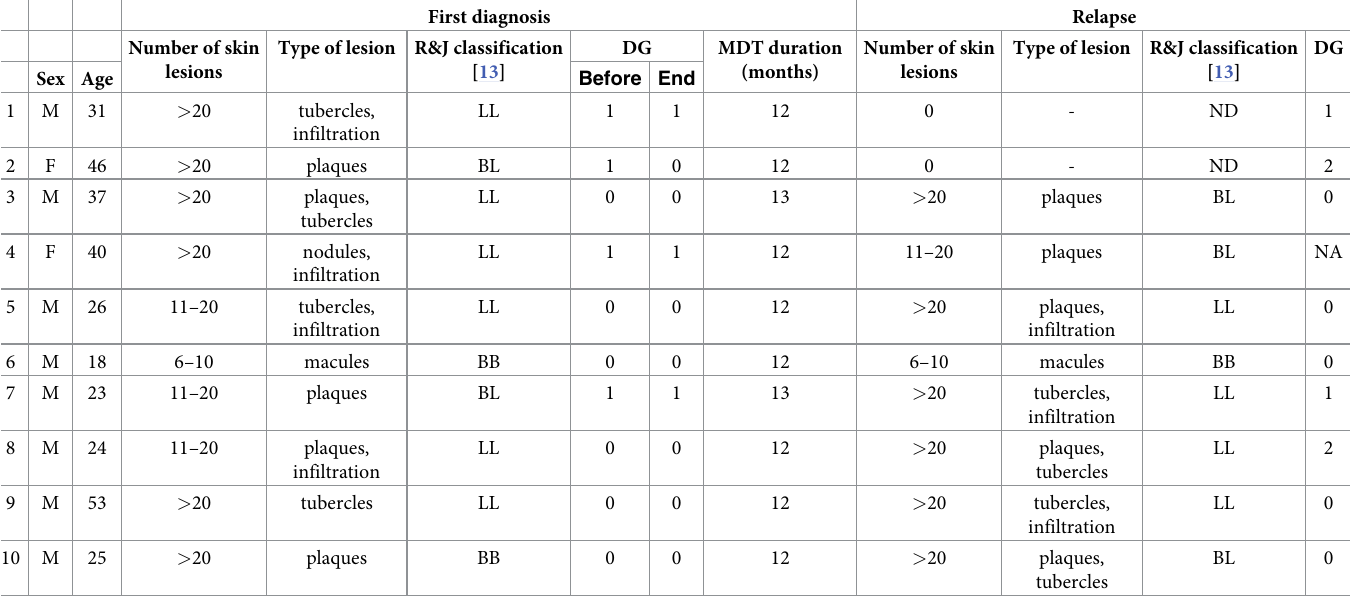
Table 2. Demographic and clinical characteristics of the ten patients diagnosed with Hansen disease relapse.